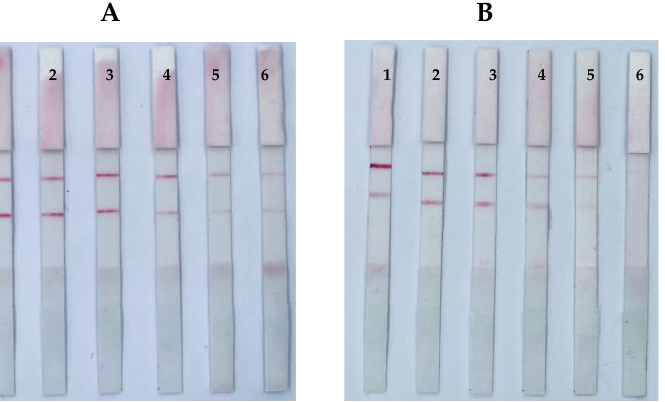
Figure 2. Optimization of pH. ICSs of ZEN ( A ), and T-2 ( B ). The pH values (labels 1–6) were 5.5, 6.0, 6.5, 7.0, 7.5, and 8.0, respectively.